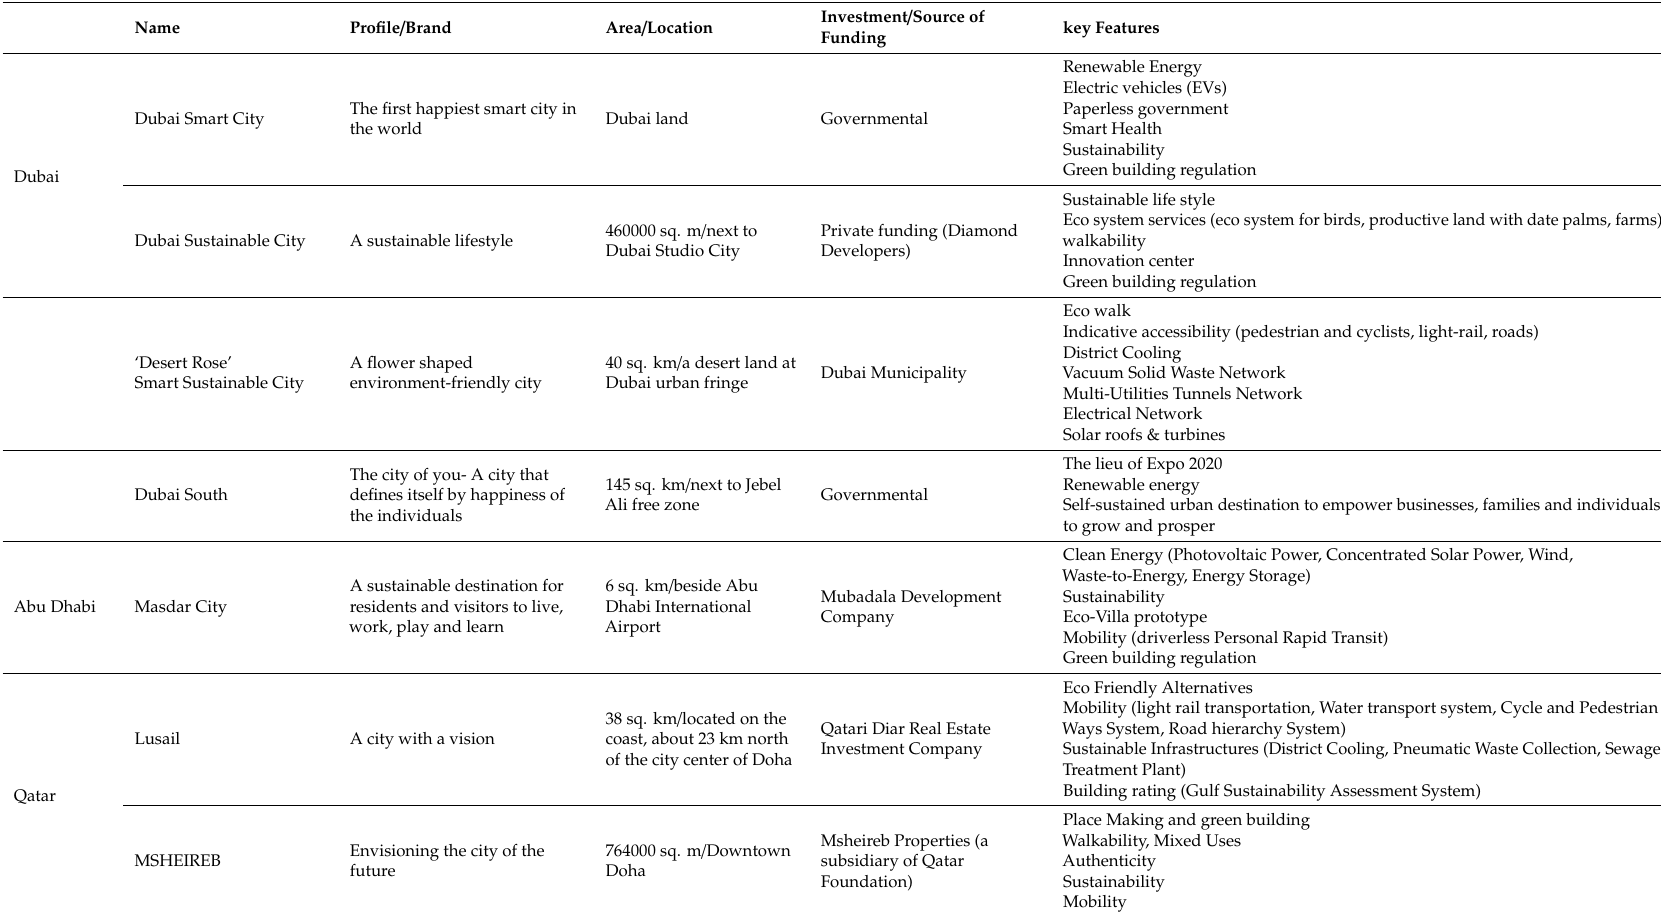
Table 5. Smart and sustainable cities and their key features in Qatar, Abu Dhabi and